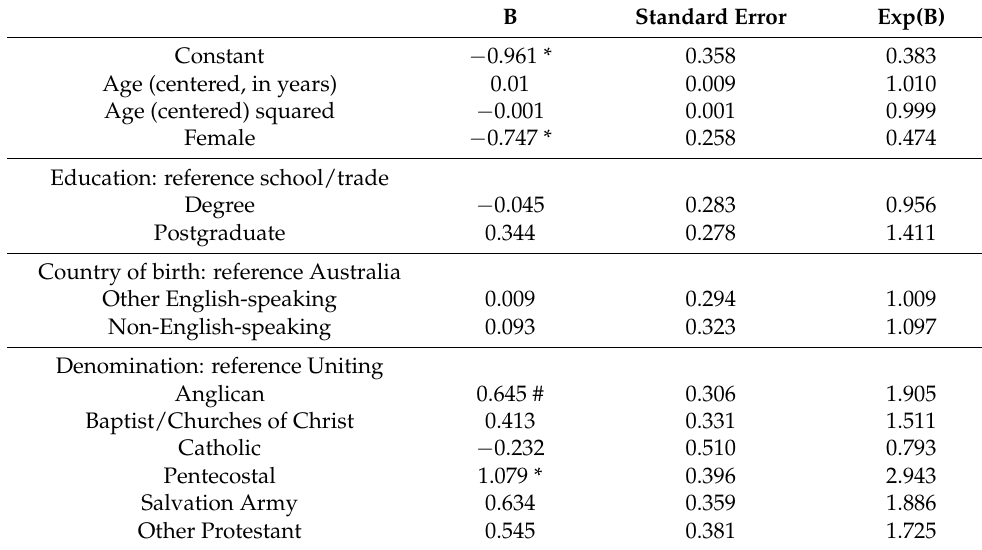
Table 7. Prediction of counselling perpetrator from demographics and denomination.